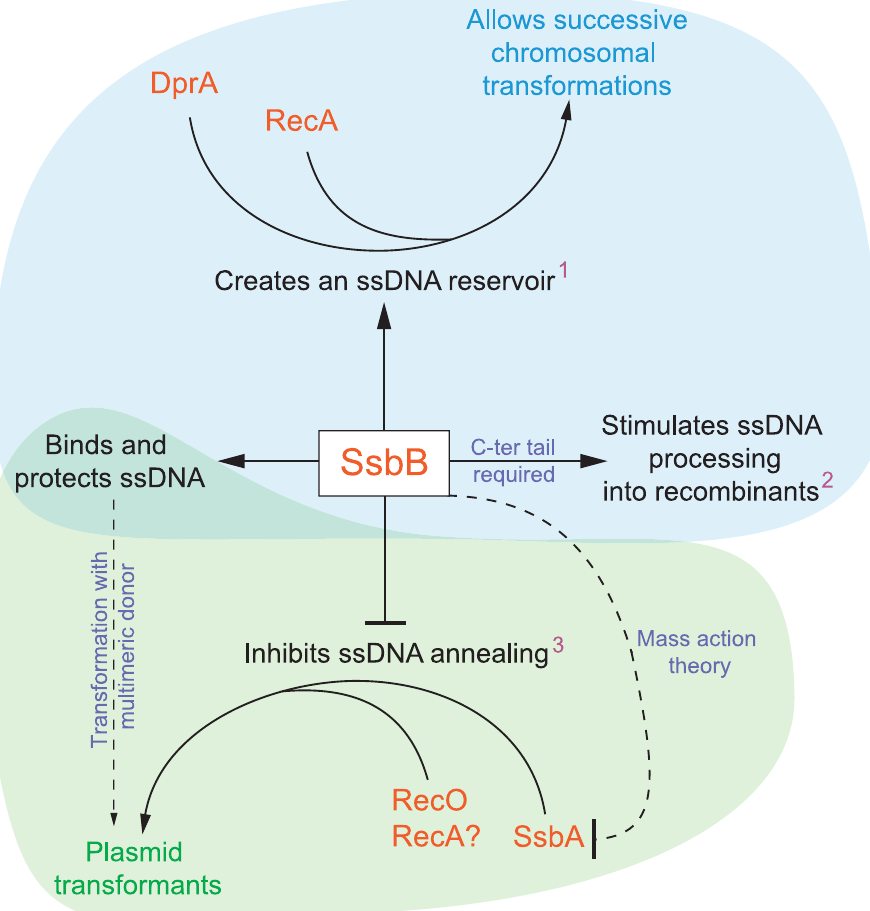
Figure 8. Diagrammatic representation of the roles of SsbB in competent cells of S.pneumoniae . SsbB binds and protects internalized ssDNA, which creates a reservoir ( 1 at high donor DNA concentration) that can be accessed by DprA and RecA [20]. This reservoir then allows successive chromosomal transformations in the same cell, which directly impacts on the generation of genetic diversity. SsbB also plays a direct, yet undetermined role in the processing of ssDNA into recombinants ( 2 independently of the amount and length of ssDNA internalized), for which the C- ter tail of the protein is required. Finally, SsbB antagonizes plasmid transformation ( 3 at high concentration of donor DNA). We suggest that while SsbA may interact with RecO and favor reconstitution of an intact plasmid replicon through RecO (or RecA) dependent single-strand annealing, SsbB does not because its Cter differs from that of SsbA; as SsbB is , 20-fold more abundant than SsbA, mass action is likely to result in SsbB preferential binding, thus preventing annealing and therefore plasmid reconstitution. Chromosomal and plasmid transformation are distinguished respectively by blue and green zones.